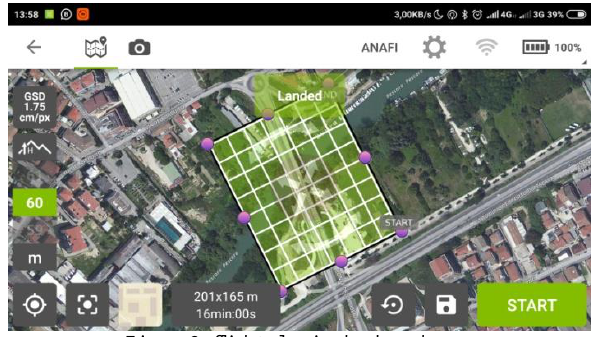
Figure 3: flight plan in checkered